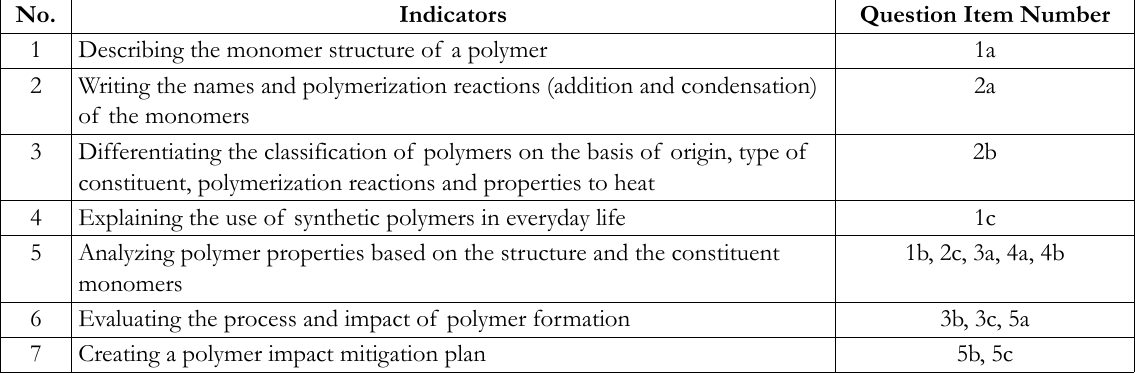
Table 1. Distribution of Polymer Concept Test Question Based on Learning